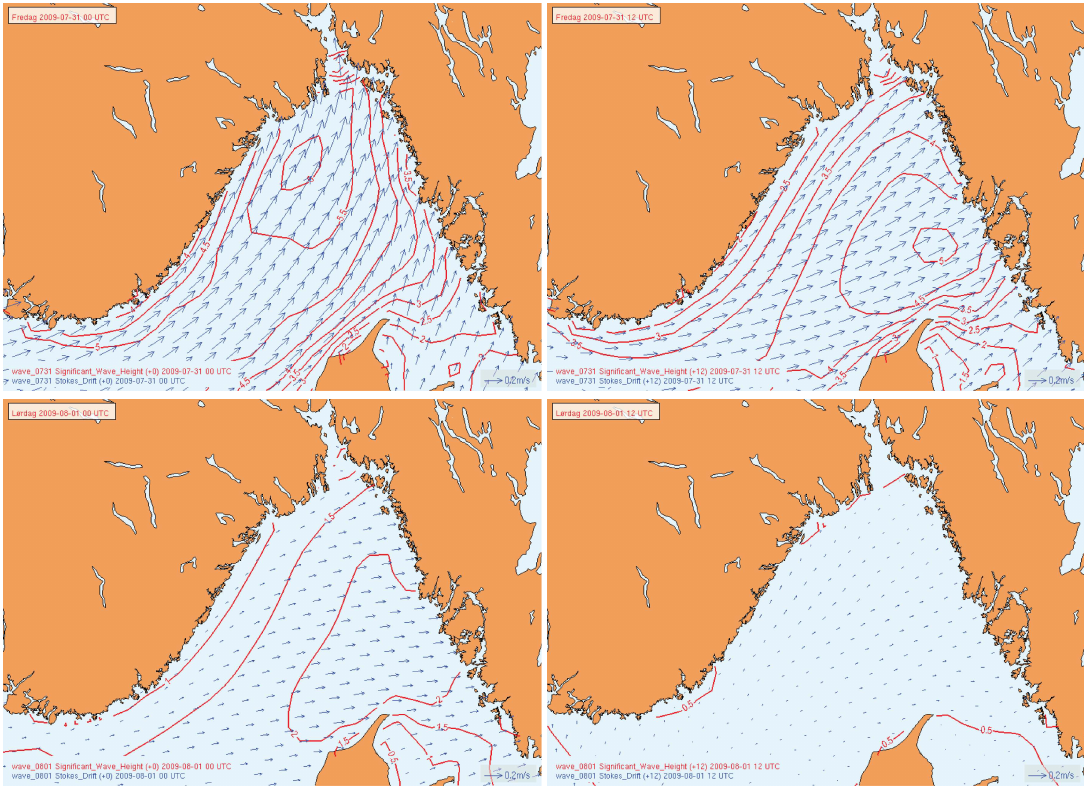
Fig. 3. Significant wave height (red contours) and Stokes drift velocity vector (blue arrows), from the model WAM4km. Upper left panel is from 31 July at 00:00; upper right panel is from 31 July at 12:00; lower left panel is from 1 August at 00:00; lower right panel is from 1 August at